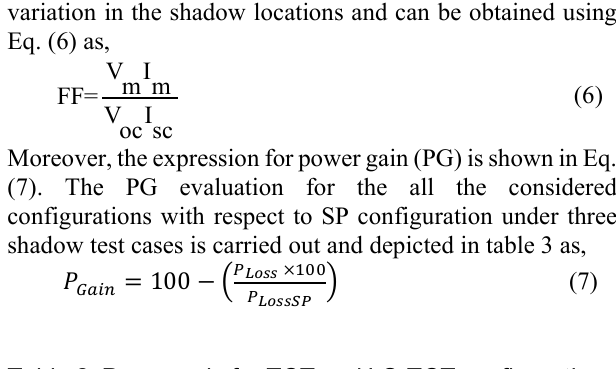
Table 2. Power gain for TCT and LS-TCT configurations with respect to SP configuration